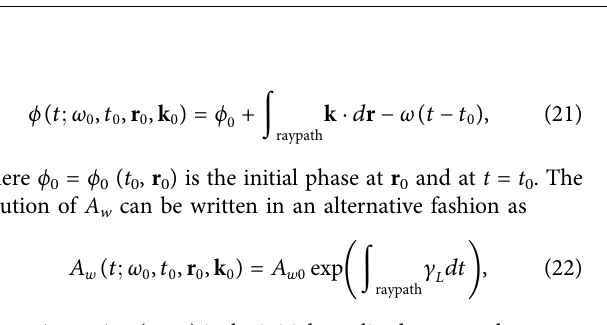
Frontiers in Astronomy and Space Sciences |